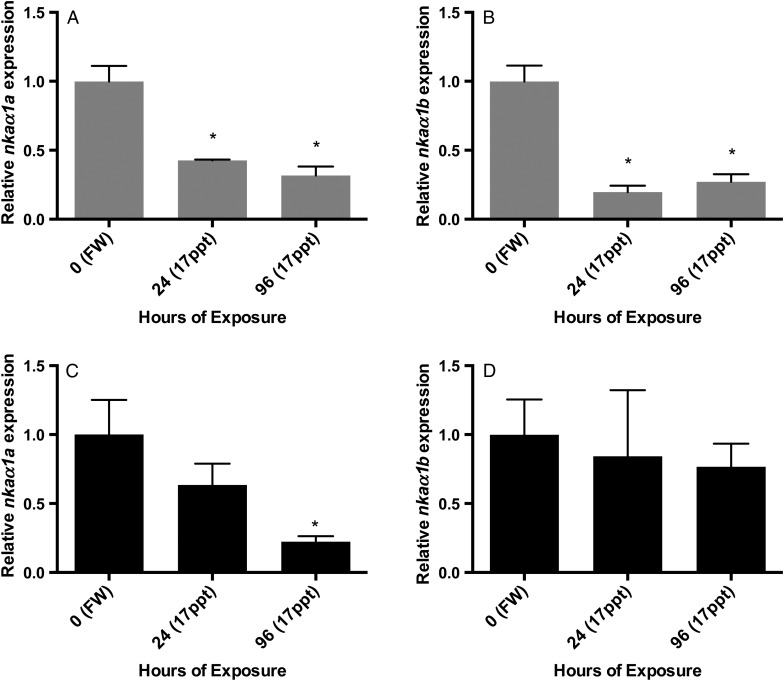
Gill expression of sodium–potassium ATPase isoforms nkaα1a and nkaα1b in Arctic graying (A and B) and rainbow trout (C and D) in freshwater (FW) and after 24 and 96 h exposure to 50% (17 ppt) seawater. Messenger RNA expression is normalized to the endogenous control gene ef1α, and significant differences from control freshwater levels are designated with an asterisk (n = 3, P < 0.05, one-way ANOVA, Dunnett's multiple comparisons test).